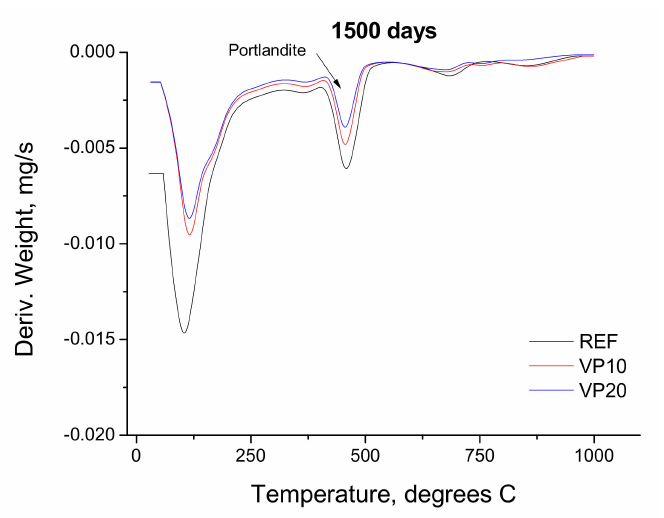
Figure 9. Derivate of weight versus temperature curve obtained for REF, VP10 and VP20 mortars after 1500 hardening days.